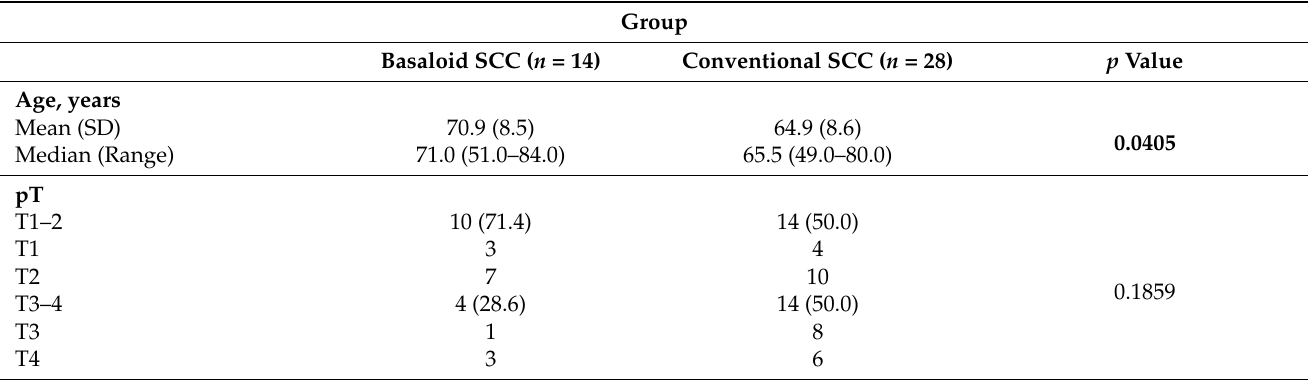
Table 1. Descriptive statistics of demographic and clinical-pathological variables, and their compari- son between laryngeal BSCC and conventional